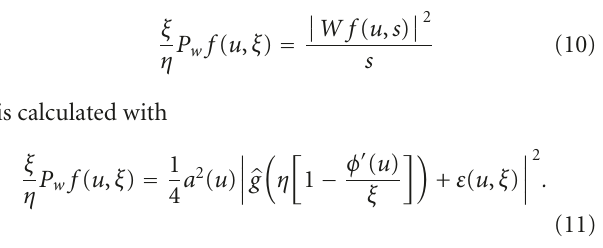
Figure 3: Wavelet ridges plot for a 40Hz signal component in signal containing 40 Hz and 240